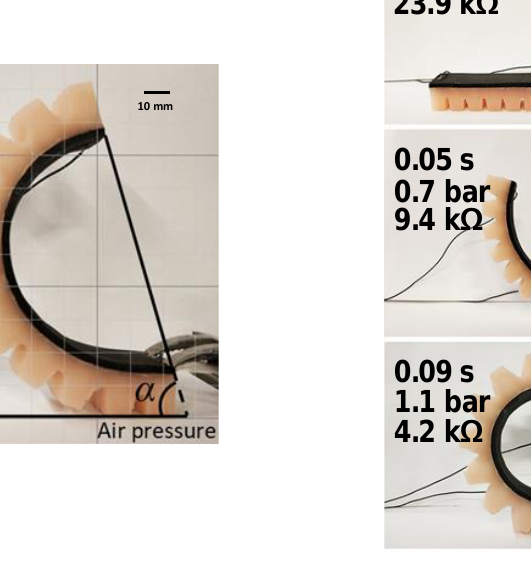
Figure 7. ( a ) Experimental set-up of self-sensing finger actuator. ( b ) Time-lapse images from high-speed video of the self-sensing finger actuator showing time, pressure and inherent